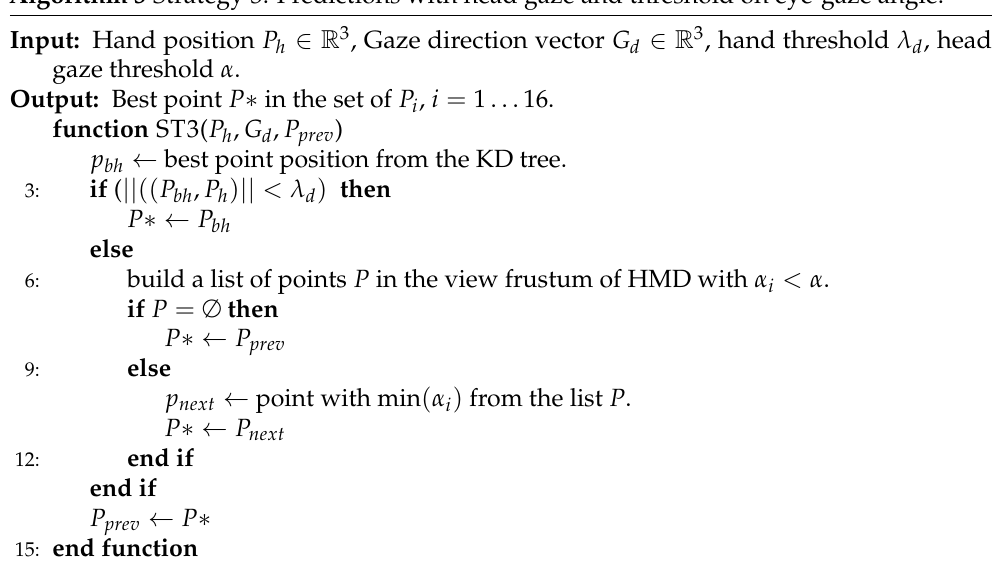
Algorithm 3 Strategy 3: Predictions with head gaze and threshold on eye-gaze angle.